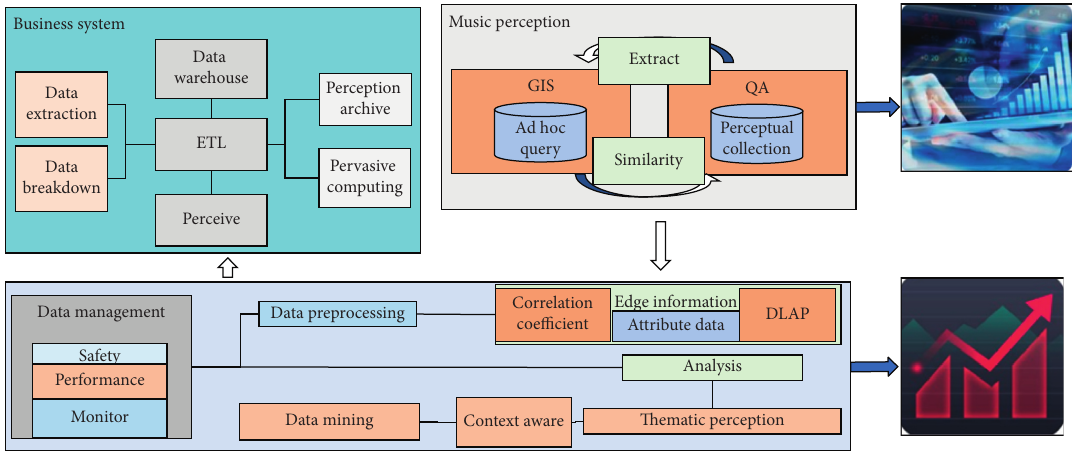
Figure 2: Context-awareness